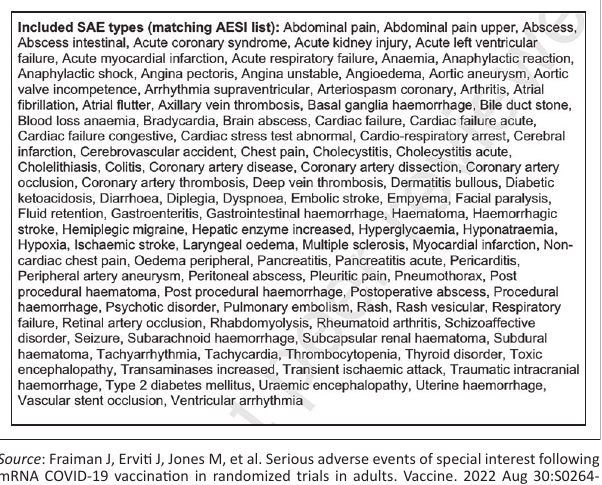
FIGURE 2: World Health Organization endorsed a list of adverse events of special interest associated with COVID-19